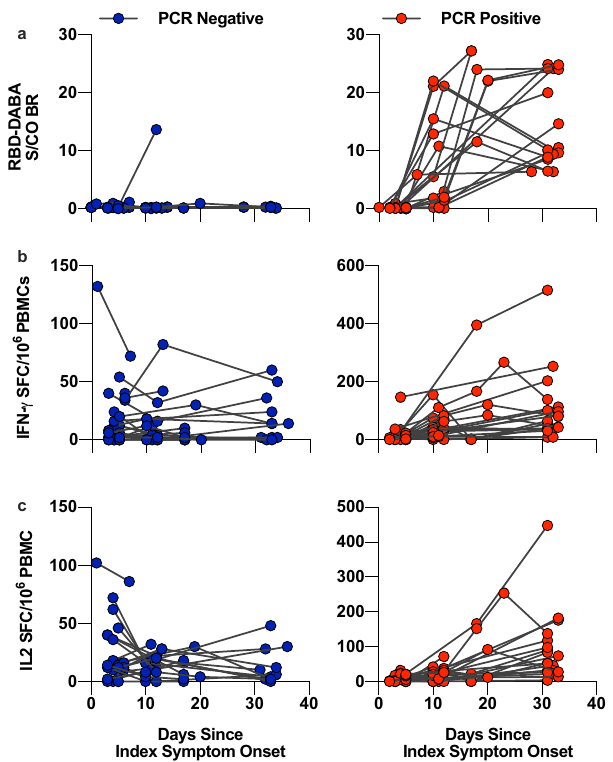
Fig. 3 Dynamics of cross-reactive T cells and RBD-speci fi c antibody in PCR-positive and negative contacts. Serum sampled from COVID-19 contacts at the baseline, D7 and D28 visit were assayed for RBD-speci fi c antibody, represented as sample/control ratios ( a ). PBMCs from these visits were rested overnight at high density prior to stimulation with 1 µ g/ml cross-reactive peptide pool cultured for 20 h in a FLISpot assay to detect IL- 2- ( b ) and IFN γ ( c ) secreting T cells. Serum from these visits were assayed for RBD-speci fi c antibody, represented as sample/control ratios ( c ). Left- hand panels and blue circles represent PCR-negative contacts whilst right- hand panels and red circle represent PCR-positive